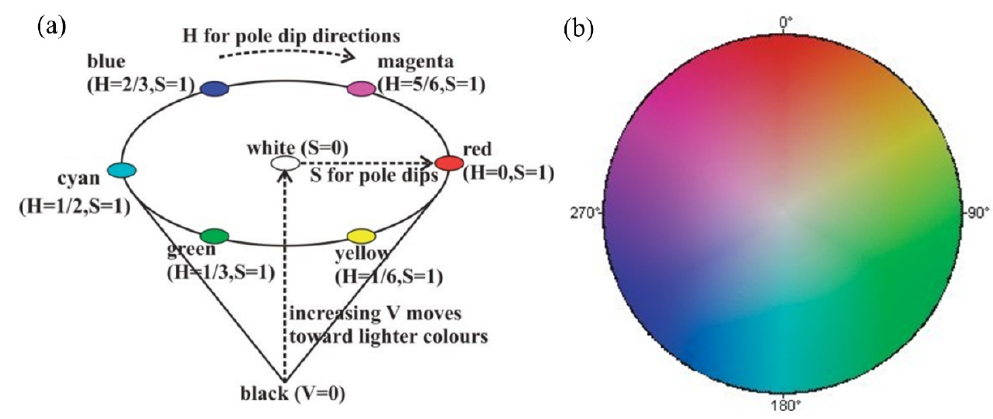
Figure 5. ( a ) HSV colour scheme; ( b ) HSV colour wheel for 3d rock structural rendering.